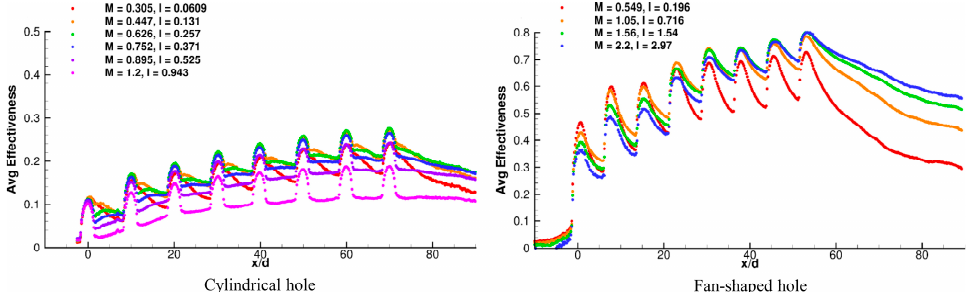
Figure 14. Lateral-averaged adiabatic effusion cooling efficiency with cylindrical holes and fan- shaped holes under various blowing ratios. Adapted with permission from [90]. Copyright 2017 ASME.